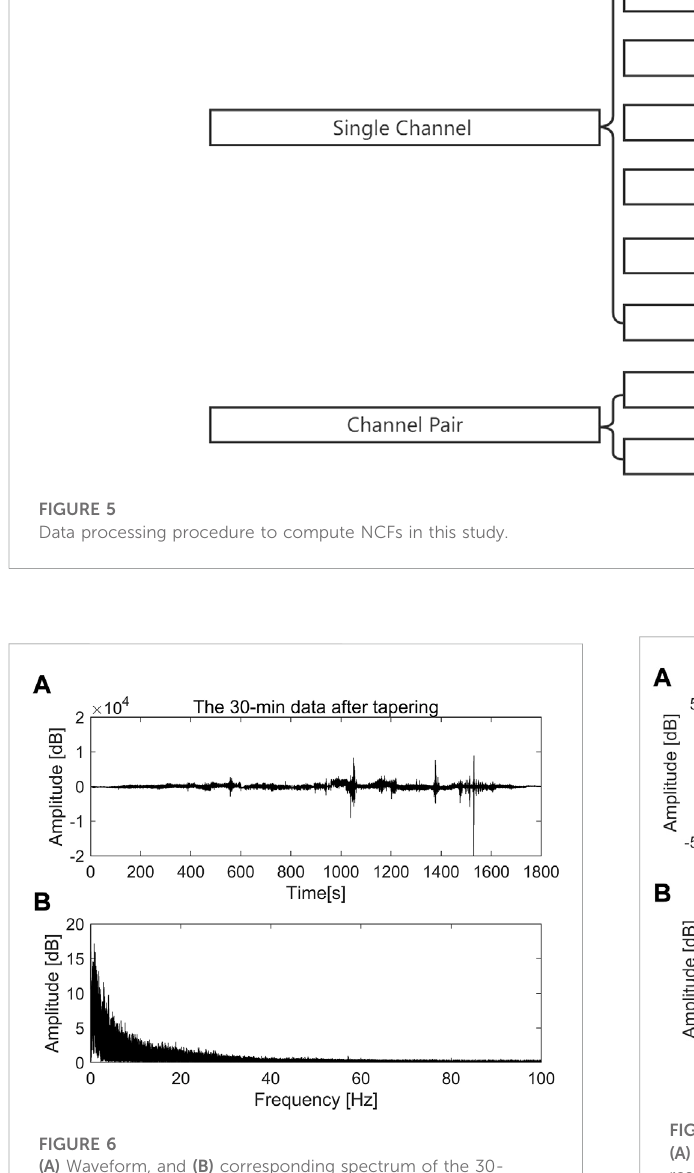
FIGURE 6 (A) Waveform, and (B) corresponding spectrum of the 30- min record of Channel 200 in Line II after tapering.